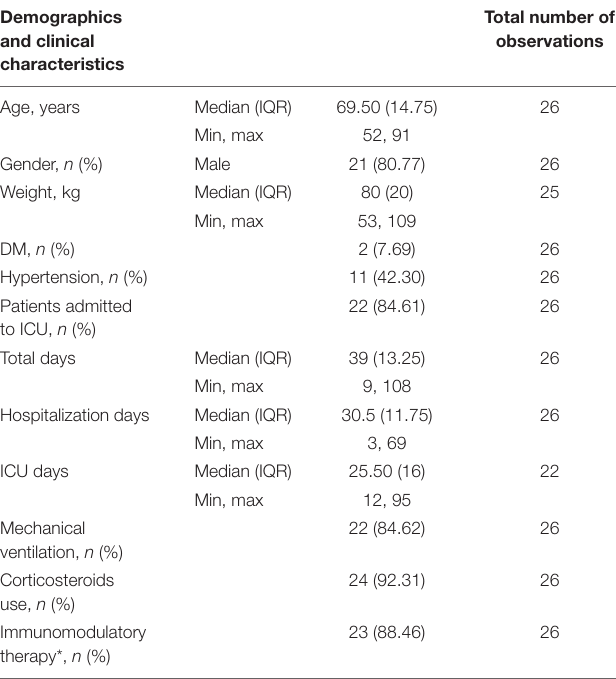
TABLE 1 | Clinical characteristics of adult